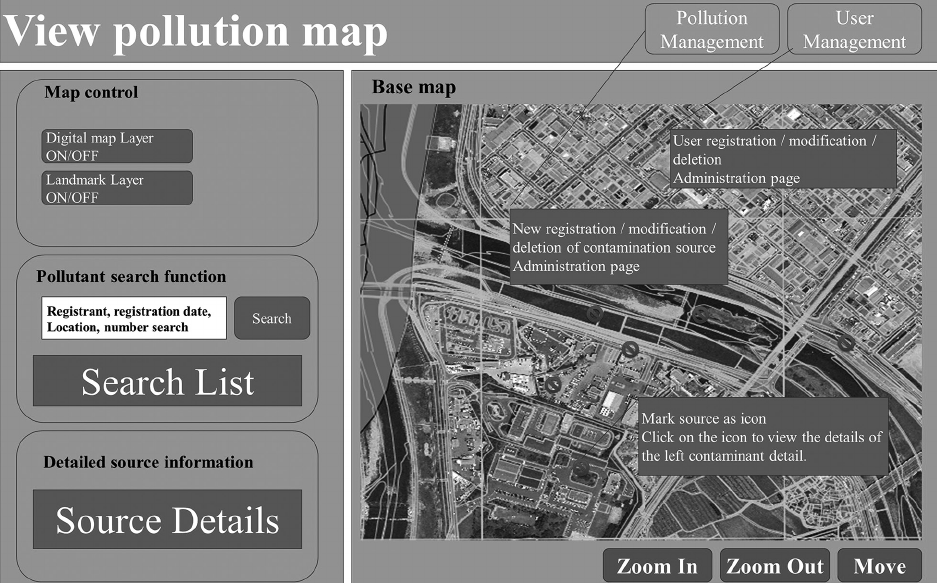
Figure 3. User interface for the search and view of pollution